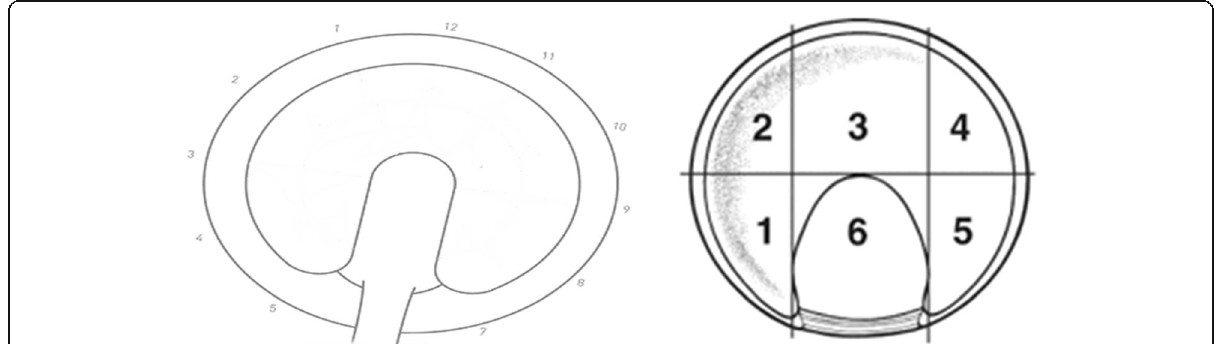
Fig. 1 Acetabular Labral Lesion Classification Systems. The right hip zones for the clock-face (left) and geographic (right) methods. Reprinted from Arthroscopy, 24 (5), Ilizaliturri, V. M. et al., A geographic zone method to describe intra-articular pathology in hip arthroscopy: cadaveric study and preliminary report, 534 – 539, 2007, with permission from Elsevier